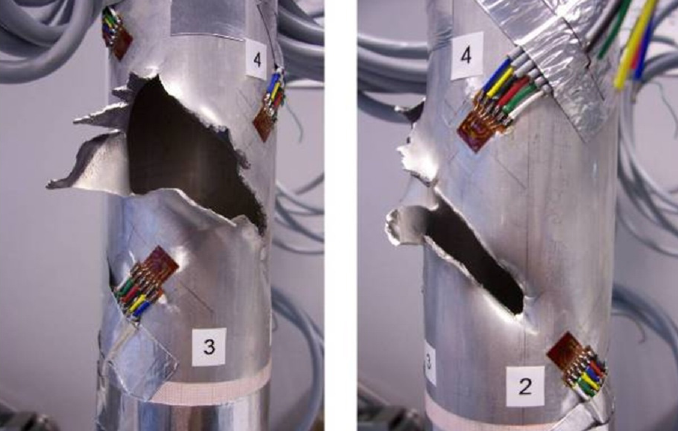
Figura 8: Posizione delle rosette.